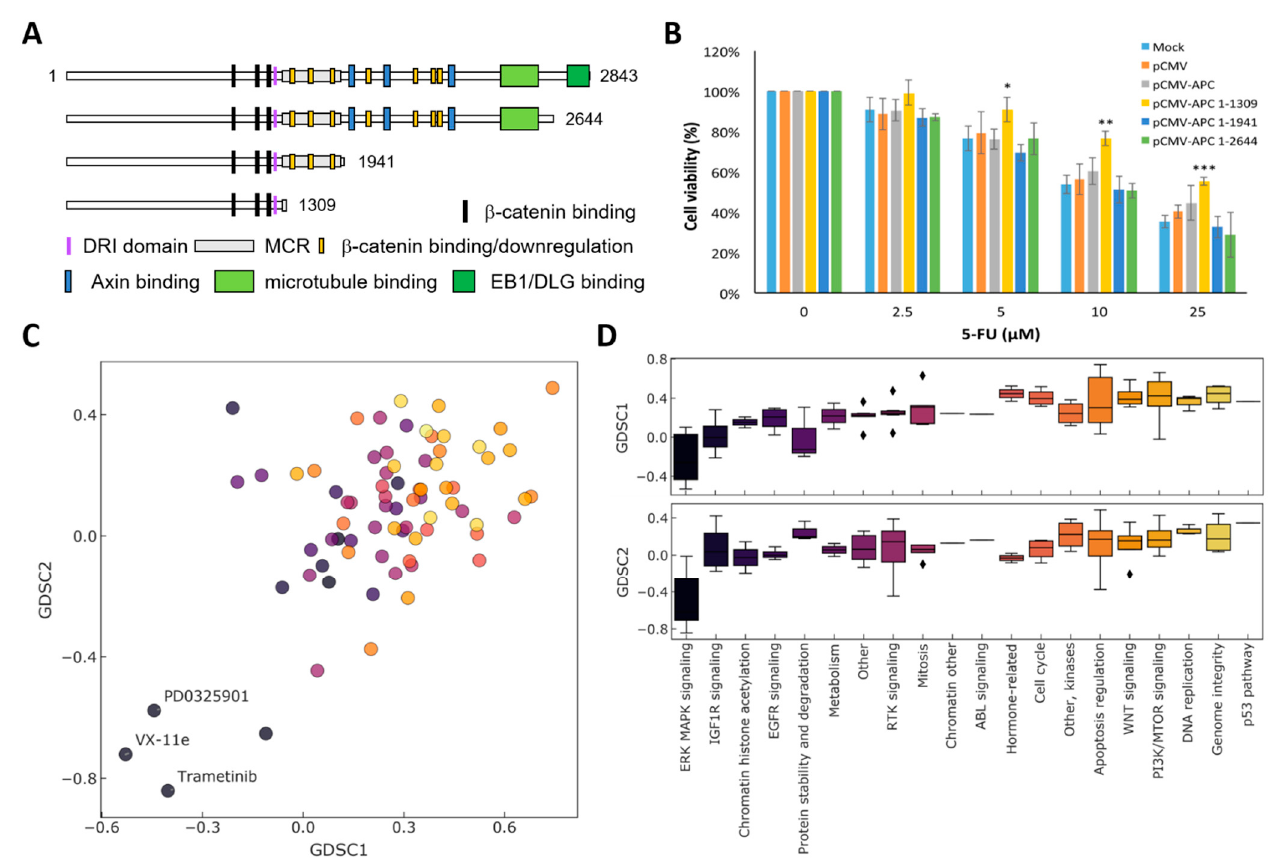
Figure 1. APC status and drug response: ( A ) C-terminal protein domains of wild-type (1-2843) and truncated APCs. Domains of APC are subsequently deleted as indicated: EB1/DLG-binding domains (1-2644), AXIN-binding (1-1941), and mutation cluster region (MRC) and β -Catenin binding/downregulation sites (1-1309). ( B ) HCT116 cells were untransfected (Mock) or transfected with pCMV harboring various truncated APCs illustrated in ( A ) with lipofectamine 3000 for 48 h. The expressing length of APC is indicated. pCMV-APC represents the full-length APC, and pCMV indicates the empty vector. After transfection, 2500 cells were seeded into 96-well plates for 16 h and treated with 5-FU at the concentration of 2.5, 5, 10, and 25 μ M for 48 h. Cell viability was then accessed by MTS assay and normalized to DMSO vehicle control. *, p < 0.05; **, p < 0.01; ***, p < 0.001. ( C ) APC status correlated drug sensitivity prediction obtained from Genomics of Drug Sensitivity in Cancer (GDSC) database. The APC mutation effects on drug sensitivity were plotted from two independent screening, GDSC1 and GDSC2. Each drug is colored by its targeting pathway in terms of the mechanism of action. Top drugs targeting ERK MAPK signaling contributed to increased sensitivity are indicated. ( D ) The effect of APC mutation on drug response is categorized by the target pathway and ranked by the mean of effects from GDSC1 and GDSC2. The color code is the same as ( C ). A negative effect indicates improved sensitivity.